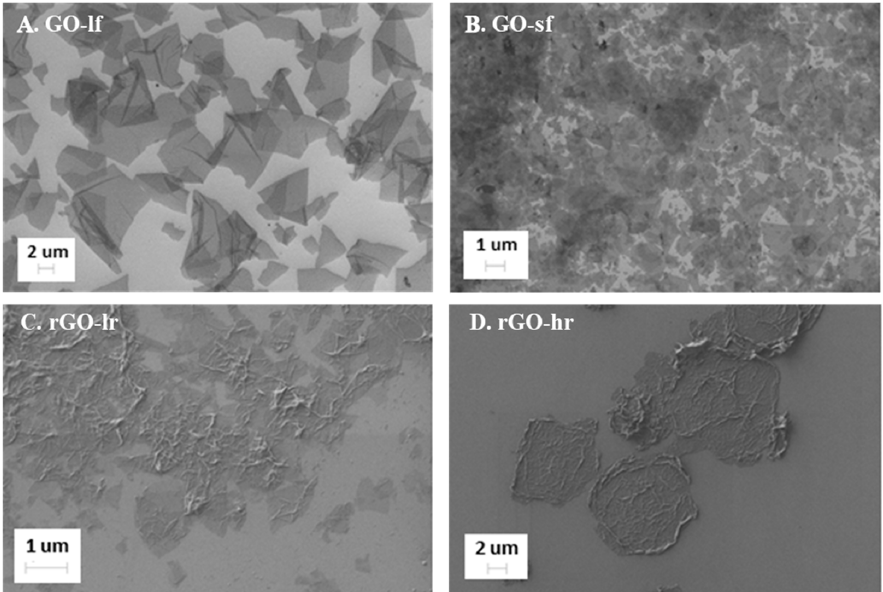
Figure 1. SEM images of the graphene oxide (GO) with large flakes (GO-lf, panel A ), GO with small flakes (GO-sf, panel B ), reduced graphene oxide (rGO) with low reduction level (rGO-lr, panel C ), and rGO with high reduction level (rGO-hr, panel D ) placed on a Si substrate. Different sizes of the GO flakes ( A, B ) and the aggregation tendency of the rGO flakes, ( C,D ) are shown.